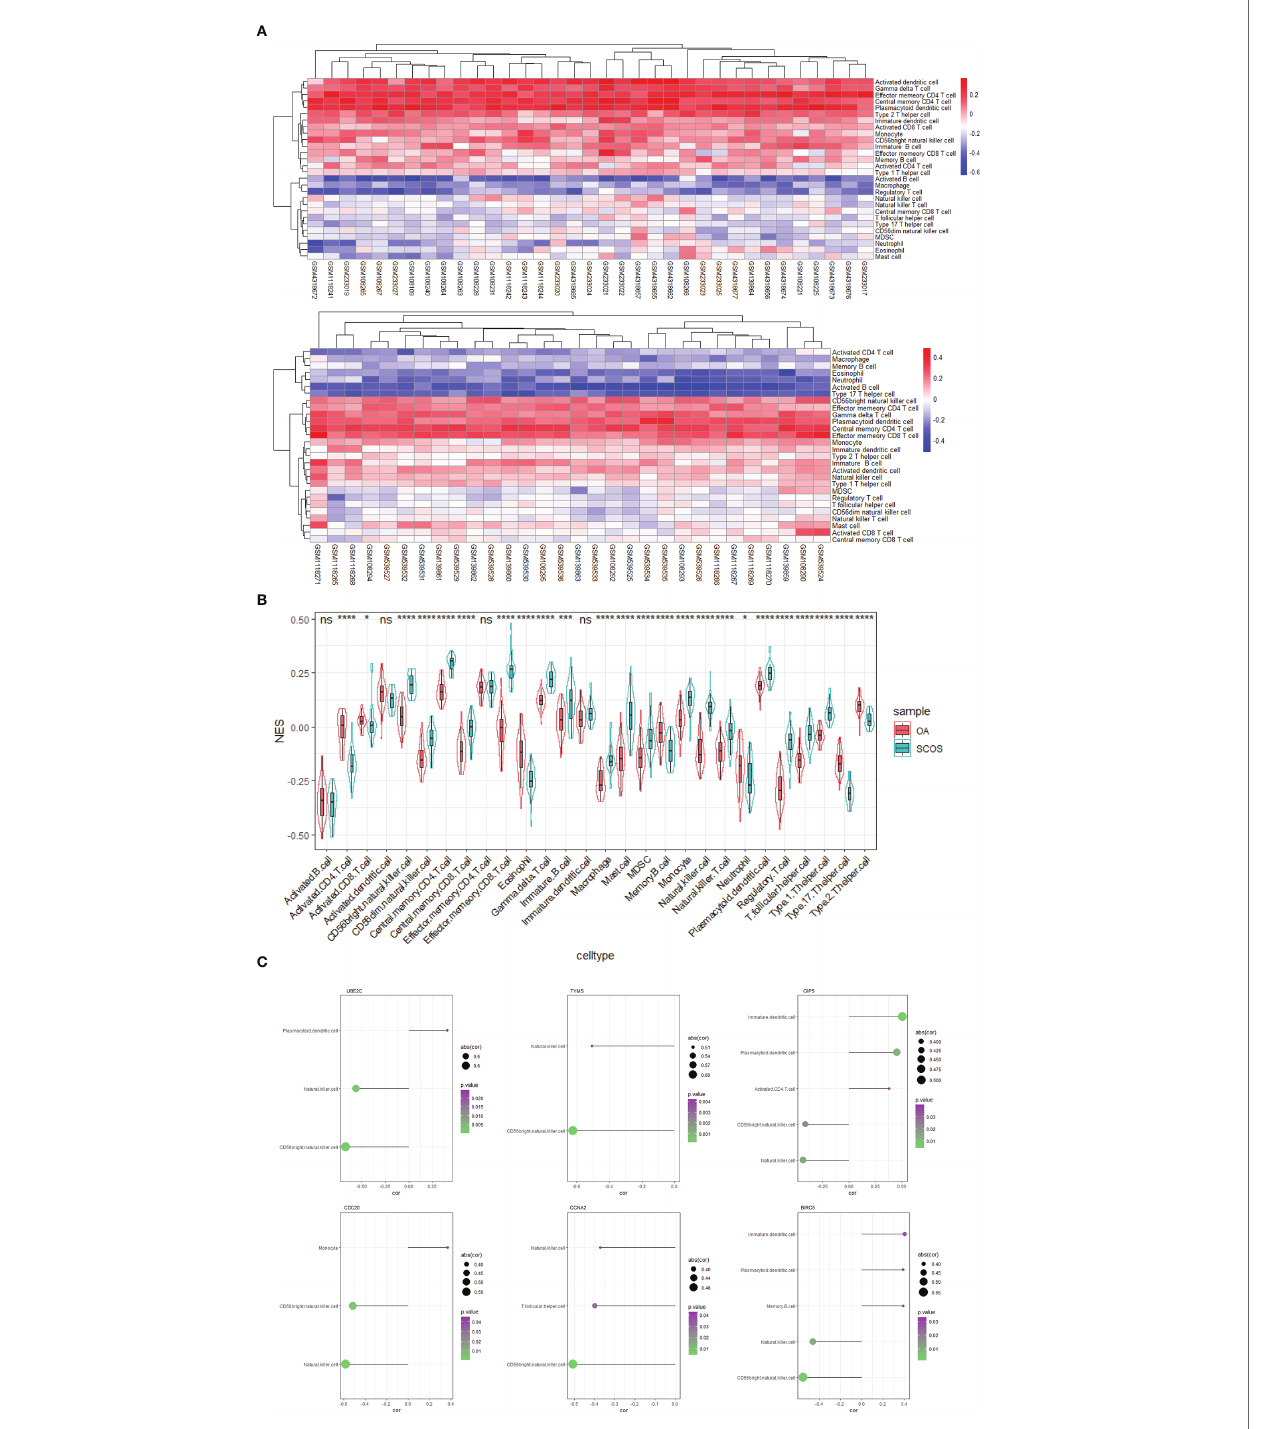
FIGURE 9 | The immune cells and OA/SCOS testicular tissue samples. (A) The heatmap summarizing the correlations between OA/SCOS testicular tissue samples and immune cells. The upper heatmap corresponds to the OA samples, while the lower heatmap corresponds to the SCOS samples. (B) Bar graph nested by violin plot exhibiting different levels of in fi ltrating immune cells between OA and SCOS testicular tissue samples. (C) The forest plots showing the signi fi cant associations between hub genes and immune cells including CD56 bright natural killer cell. NES, normalized enrichment score; OA, obstructive azoospermia; SCOS, Sertoli cell-only syndrome. *P value < 0.05; ***P value < 0.001; ****P value < 0.0001; ns, no signi fi